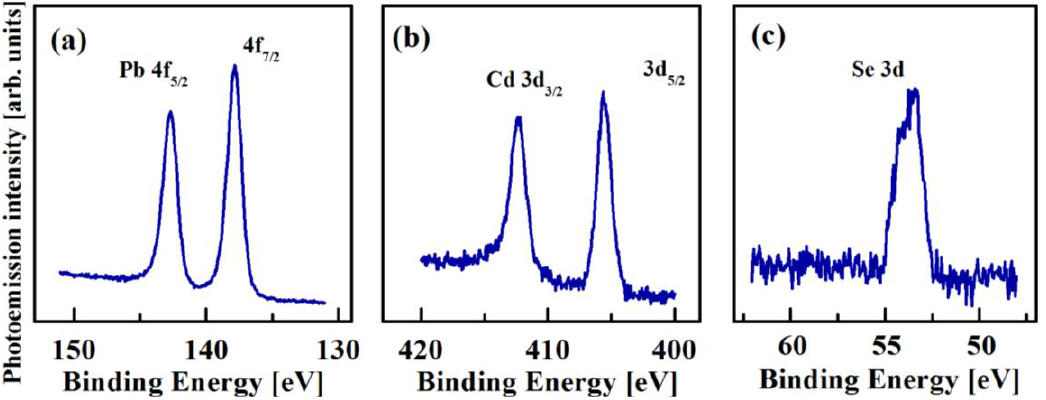
Figure 12. XPS spectra of air-free PbSe/CdSe QDs with R S /R C = 2.3/2 nm. ( a ) Pb 4f peak; ( b ) Cd 3d peak; ( c ) Se 3d